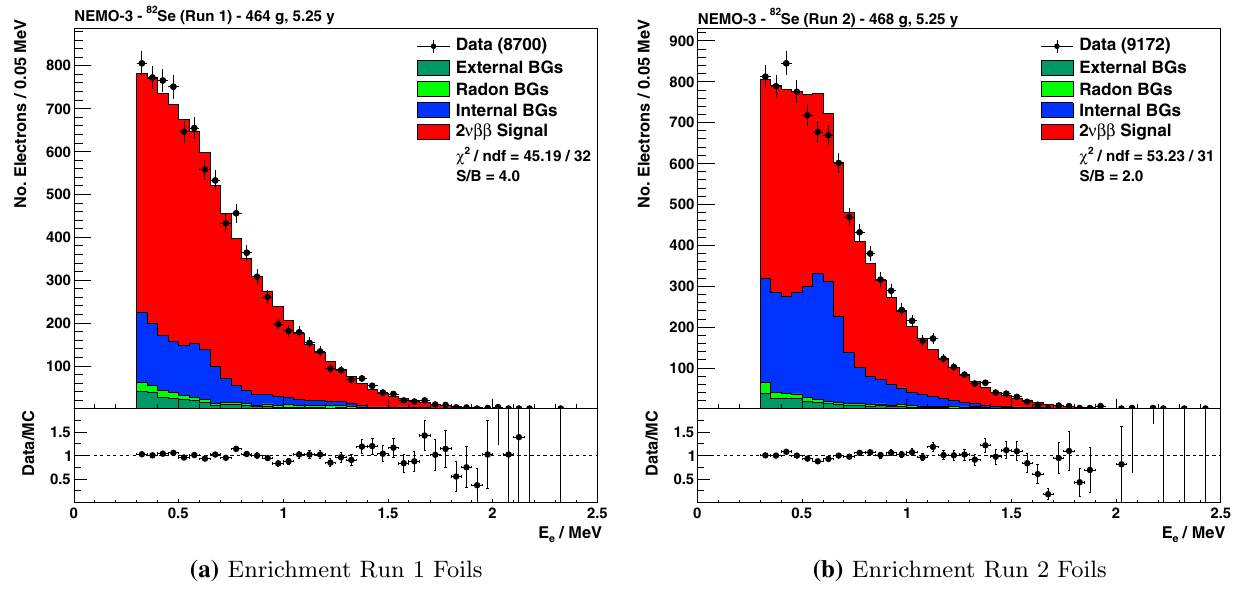
Fig. 6 Energy distribution of individual electrons in the ββ channel for foils from each enrichment run, showing a comparison of the data to the predicted spectrum from MC. The two electrons in each event are entered separately into this distributions. The higher level of 234m Pa